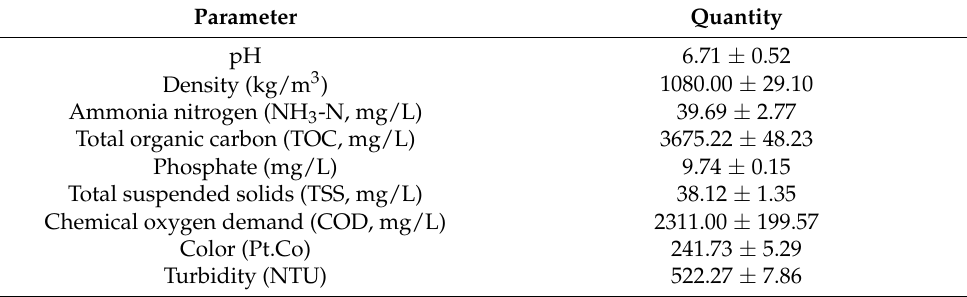
Table 3. Characteristics of the